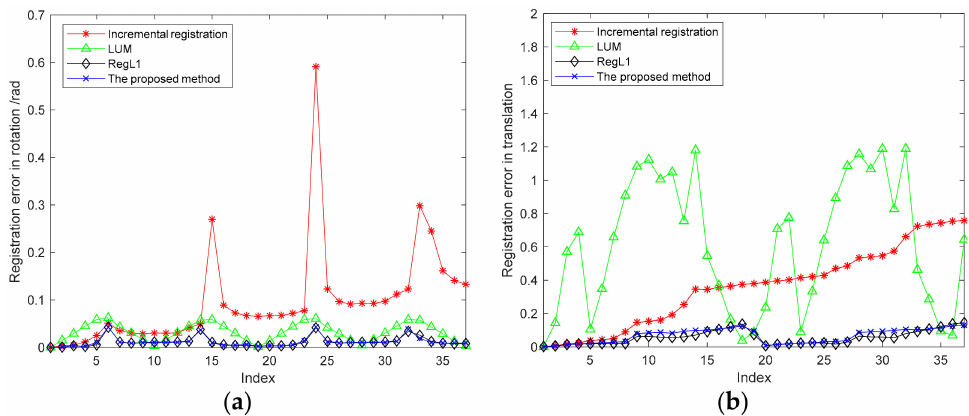
Figure 7. The relation between registration error and the index of view. ( a ) Registration error in rotation; ( b ) registration error in translation.